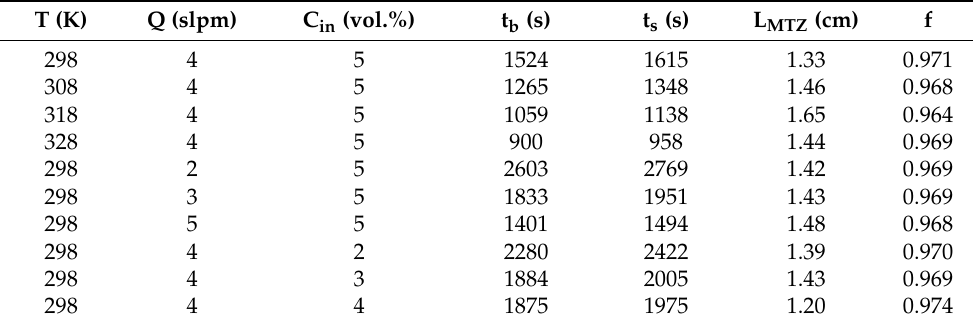
Table 8. Characteristic parameters of CO 2 adsorption for produced porous